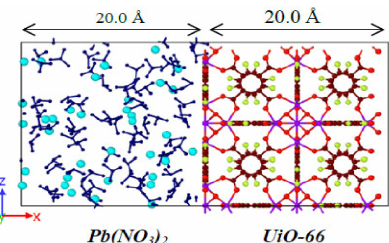
Figure 4. Snapshot of a simulation system at t = 0 ns, containing 37 Pb 2 + ions and 74 NO 3 − ions. Color code: Maroon (C in UiO-66), Red (O in UiO-66), Purple (Zr in UiO-66), Green (H in UiO-66), Navy Blue (NO 3 − ), and Cyan (Pb 2 + ). Water molecules are not shown in the figure for clarity (Ref. [36]).